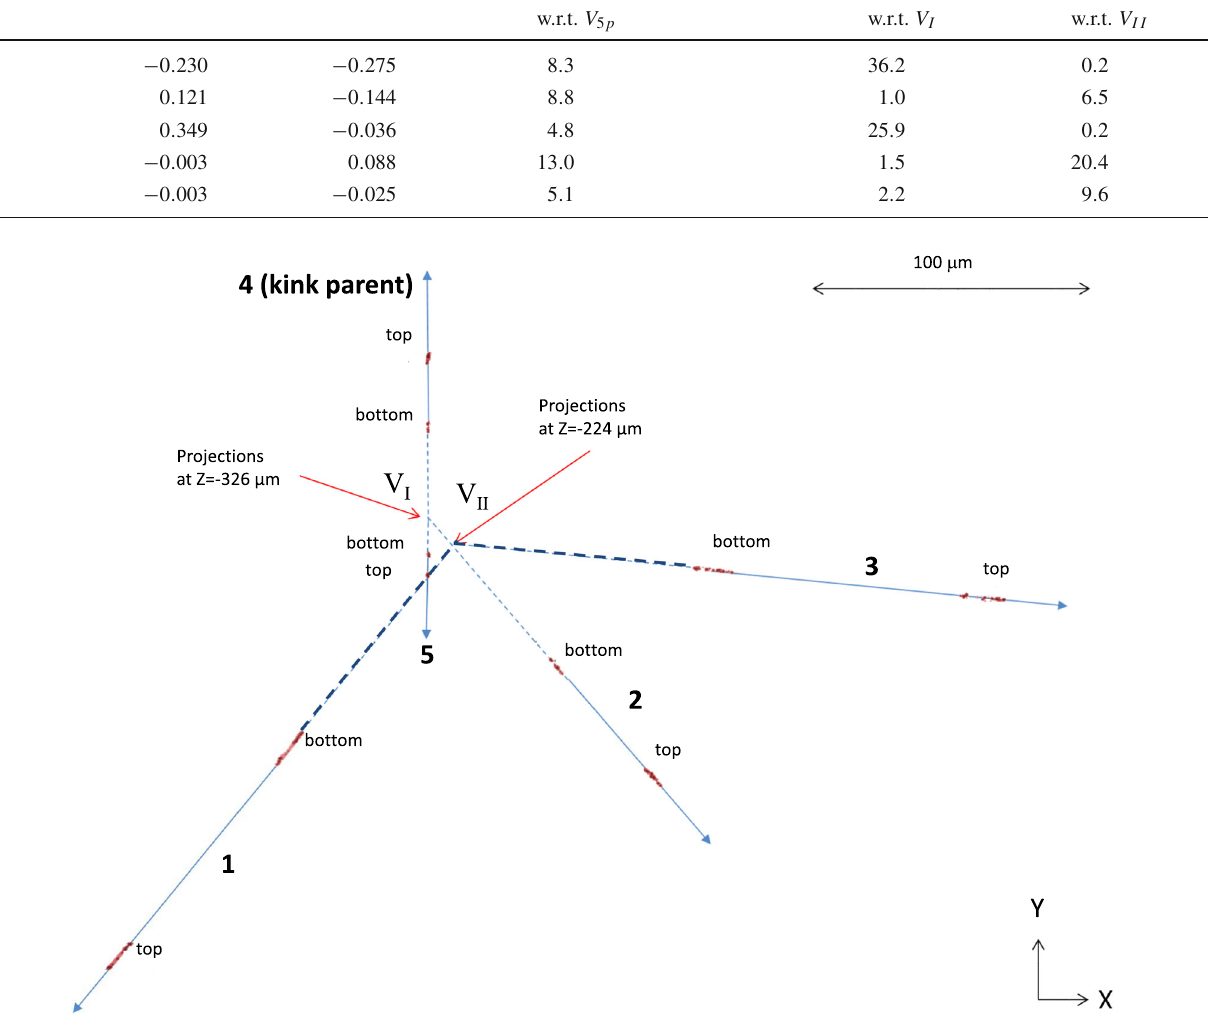
Fig. 4 Superposition of several tomographic emulsion images taken at differentdepthsalongfilm32.Imagesareprocessedtoshowonlygrains related to the events. Each track is composed by two sets of grains, one for each sensitive layer (upstream, downstream) of film 32. X and Y are transverse coordinates while the Z axis is in the neutrino beam direc-